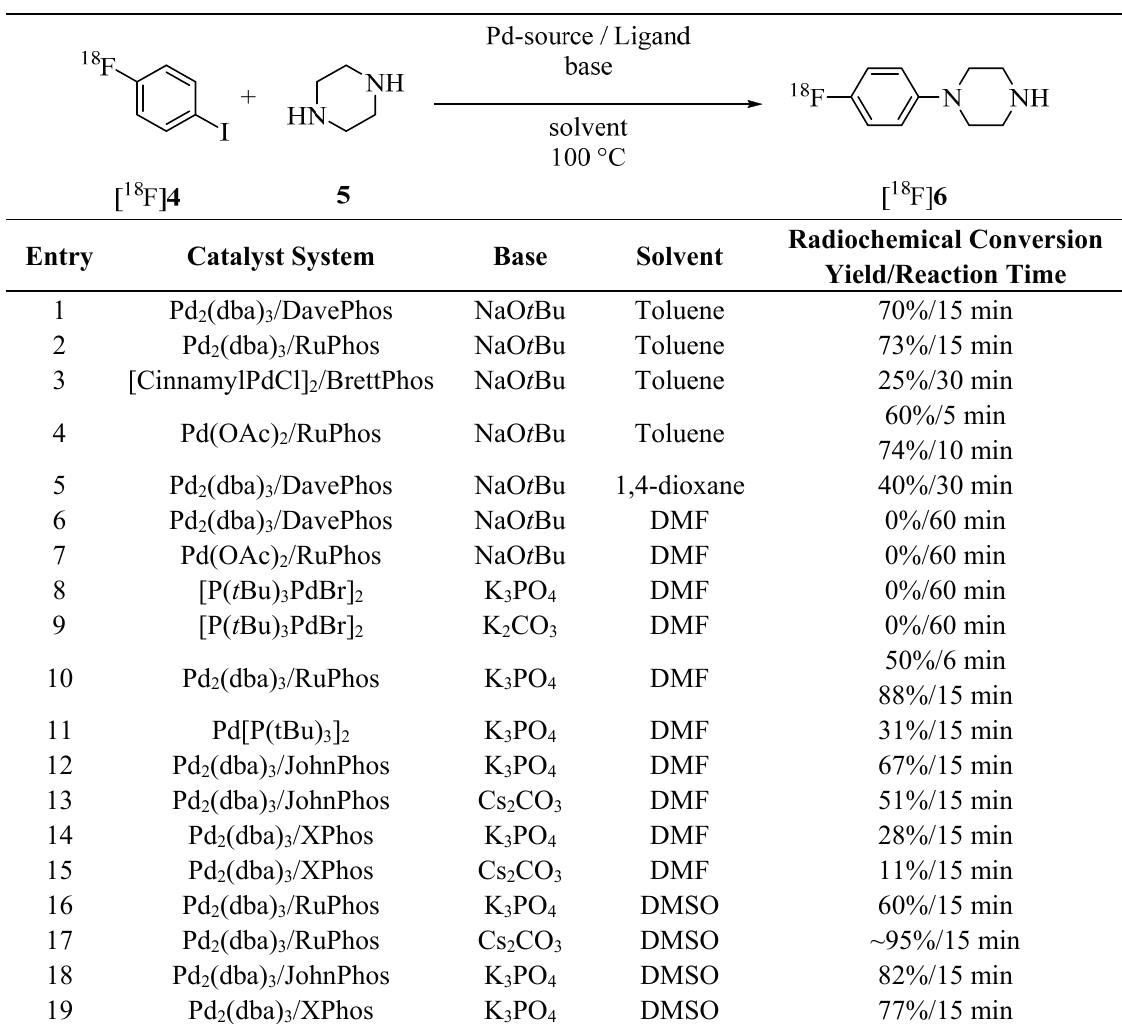
Table 1. HBC of 1-[ 18 F]fluoro-4-iodobenzene ([ 18 F] 4 ) and piperazine. Total RCY is related to coupling yields based on [ 18 F] 4